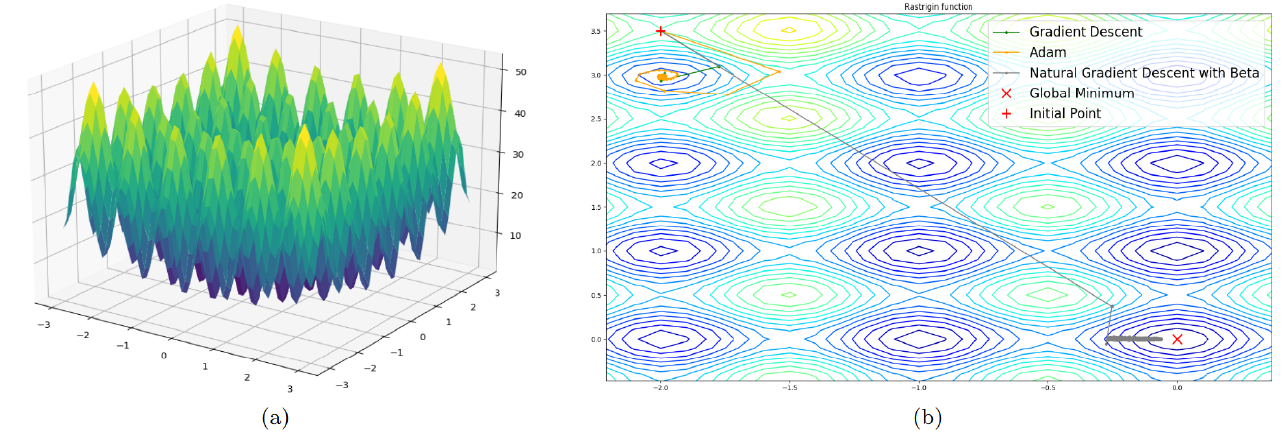
Figure 5. Experiment on Rastrigin function: ( a ) the appearance of the function; ( b ) the trajectory of movement to a minimum using various algorithms.